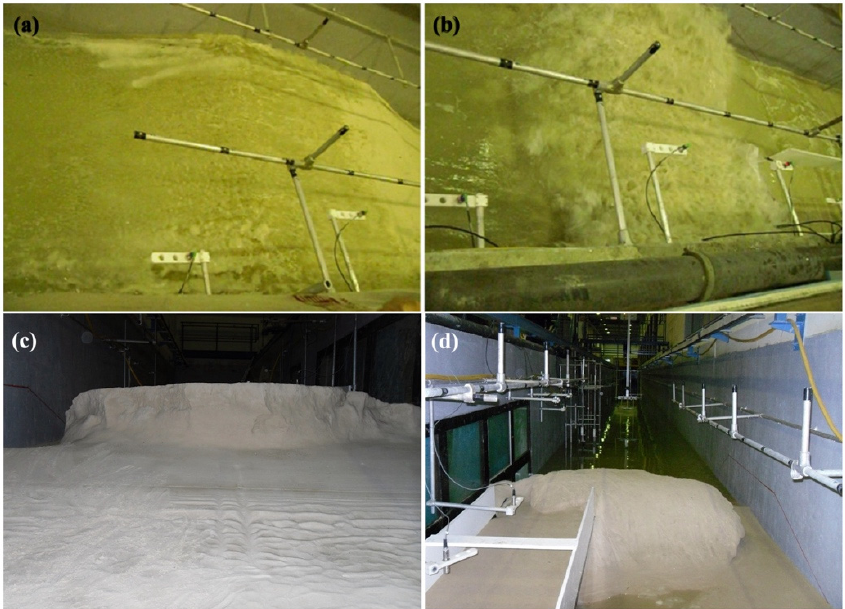
Figure 5. Observed overwash ( a , b ) and breaching ( c , d ) regimes. Hydralab ‐ III BOB project at CIEM wave flume. Photo courtesy of Felice D’Alessandro.